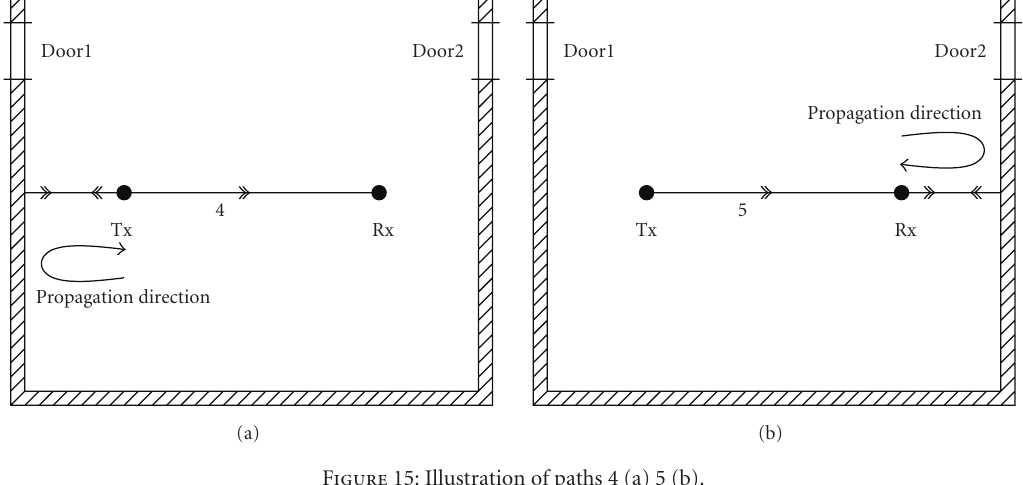
Figure 15: Illustration of paths 4 (a) 5 (b).